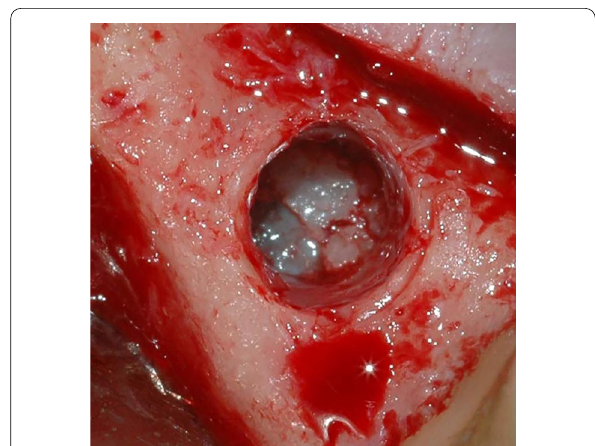
Fig. 1 Direct visual check of Schneiderian membrane integrity after crestal osteotomy performed with specific burs for transcrestal sinus approach